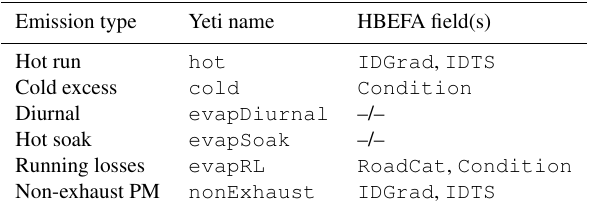
Table 2. Additional data fields derived from the HBEFA database required for different emission